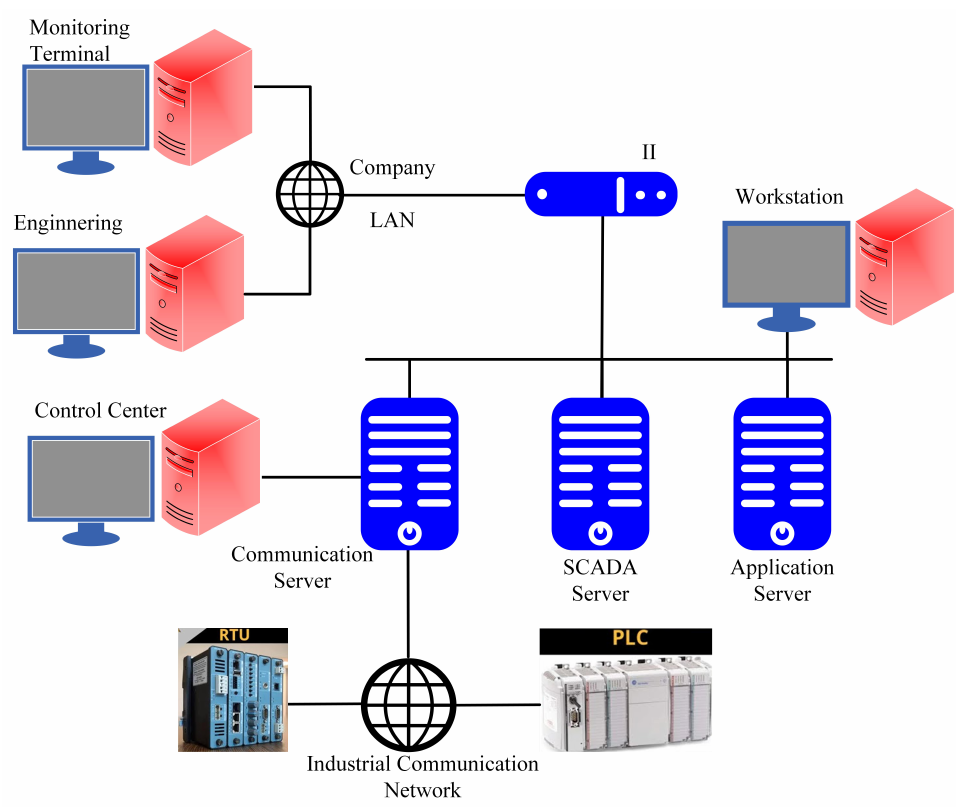
Figure 2. Illustration of a SCADA, data-acquisition devices, servers, workstations, and user terminals, in which data are exchanged over a Local Area Network (LAN) between